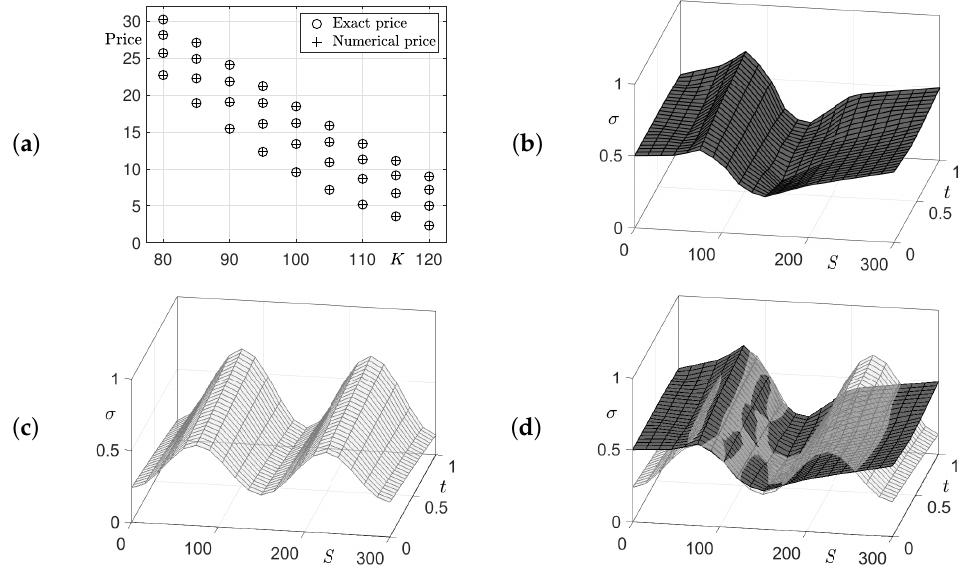
Figure 5. ( a ) Option prices computed using the given and reconstructed local volatility func- tions. ( b ) Reconstructed local volatility function. ( c ) Given local volatility function σ ( S , t )